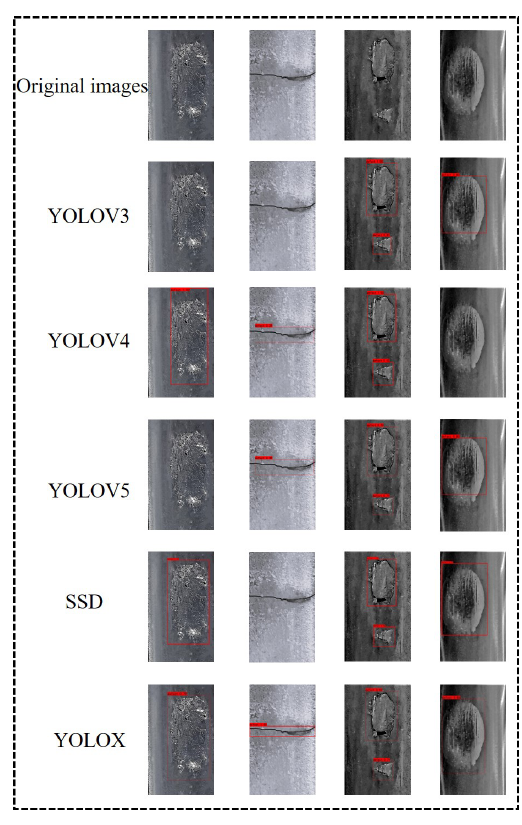
Fig. 9. The detection results of different real-time